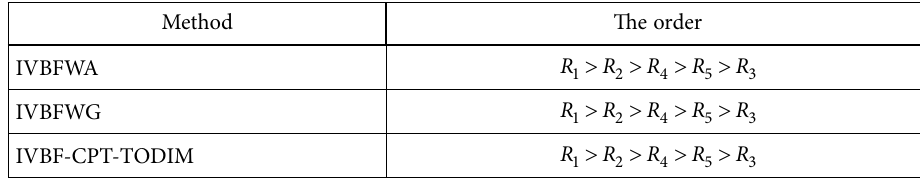
Table 10. Comparison of the final orders of different methods Method The